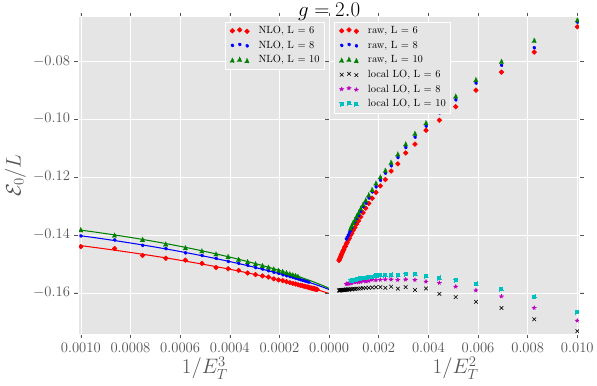
Figure 1 . Convergence of NLO-HT vs other HT